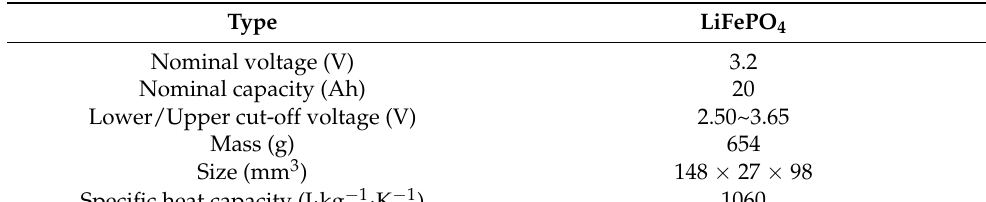
Figure 2. The battery test platform.